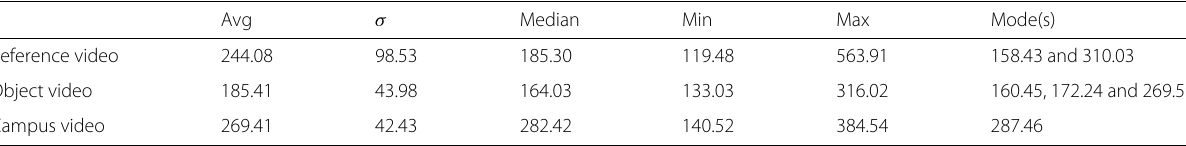
Table 1 Basic statistics for the instruction count (MI) Avg σ